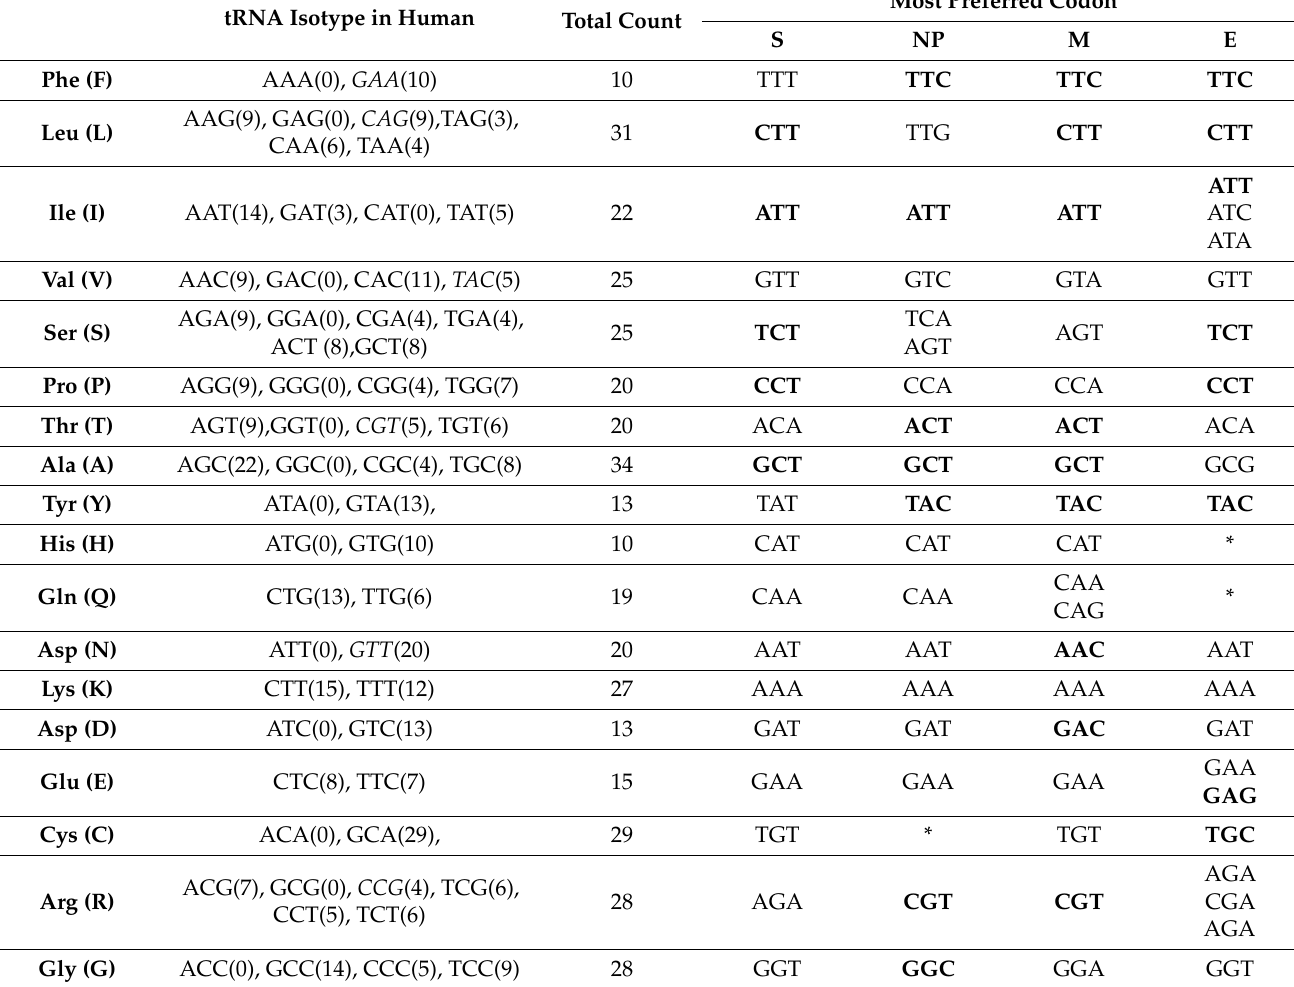
Table 6. Table for human tRNA isotype in human cells. The preferred codons corresponding to the most abundant tRNA pool are given the bold font in each row corresponding to each gene. * The amino acid is absent in a particular gene. The isoacceptor tRNAs used in disrupted codon pair construct are given in